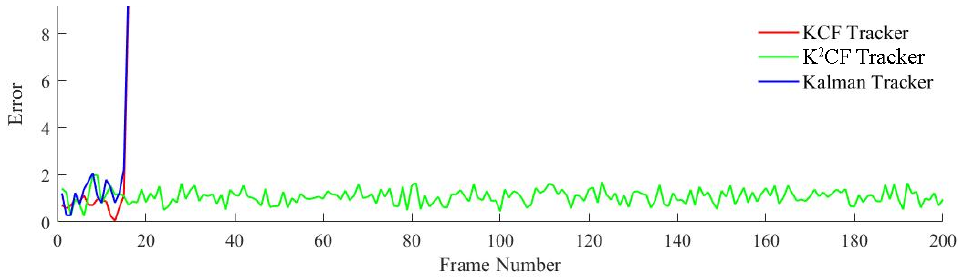
Figure 19. Detection error of nonuniform acceleration state.